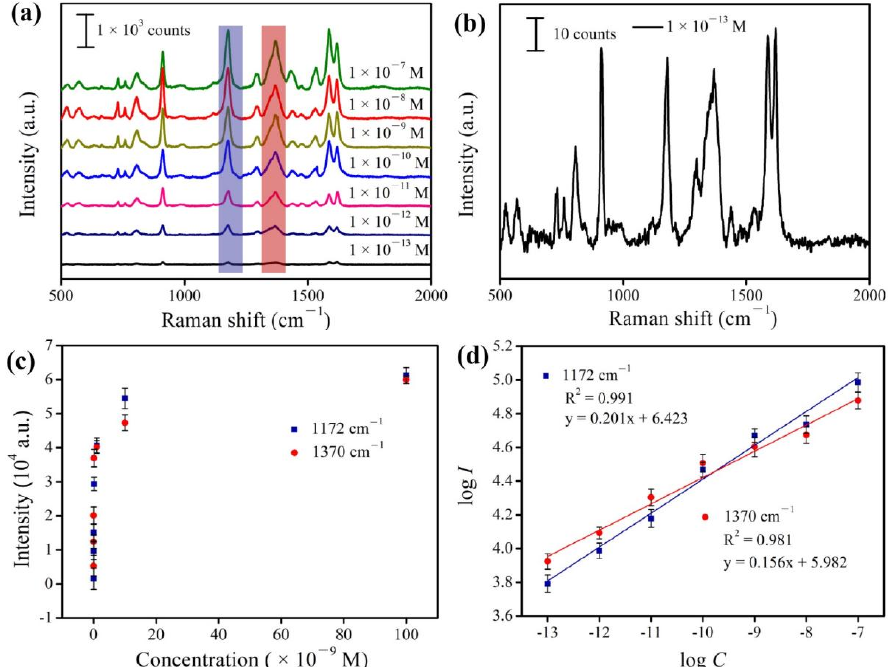
Figure 8. ( a ) Raman spectra of CV solution with different concentrations on Ag 25 -C-fiber substrate; ( b ) Raman spectra of 10 −13 M CV absorbed on Ag 25 -C-fiber substrate; ( c ) Raman signal intensities at main peaks of CV at different concentrations; ( d ) linear calibration plots between the Raman signal intensity and CV